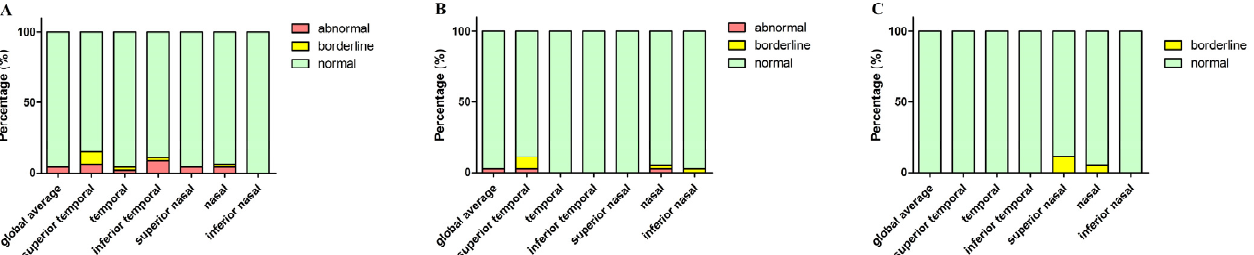
Figure 5. The percentage of three levels (based on Spectralis normative data) of pRNFL thickness (diameter of 3.5 mm) in PD, MSA, and PSP groups. ( A ) Parkinson’s disease; ( B ) MSA, multiple system atrophy; ( C ) PSP, progressive supranuclear palsy. Abbreviations: pRNFL, peripapillary retinal nerve fiber layer.